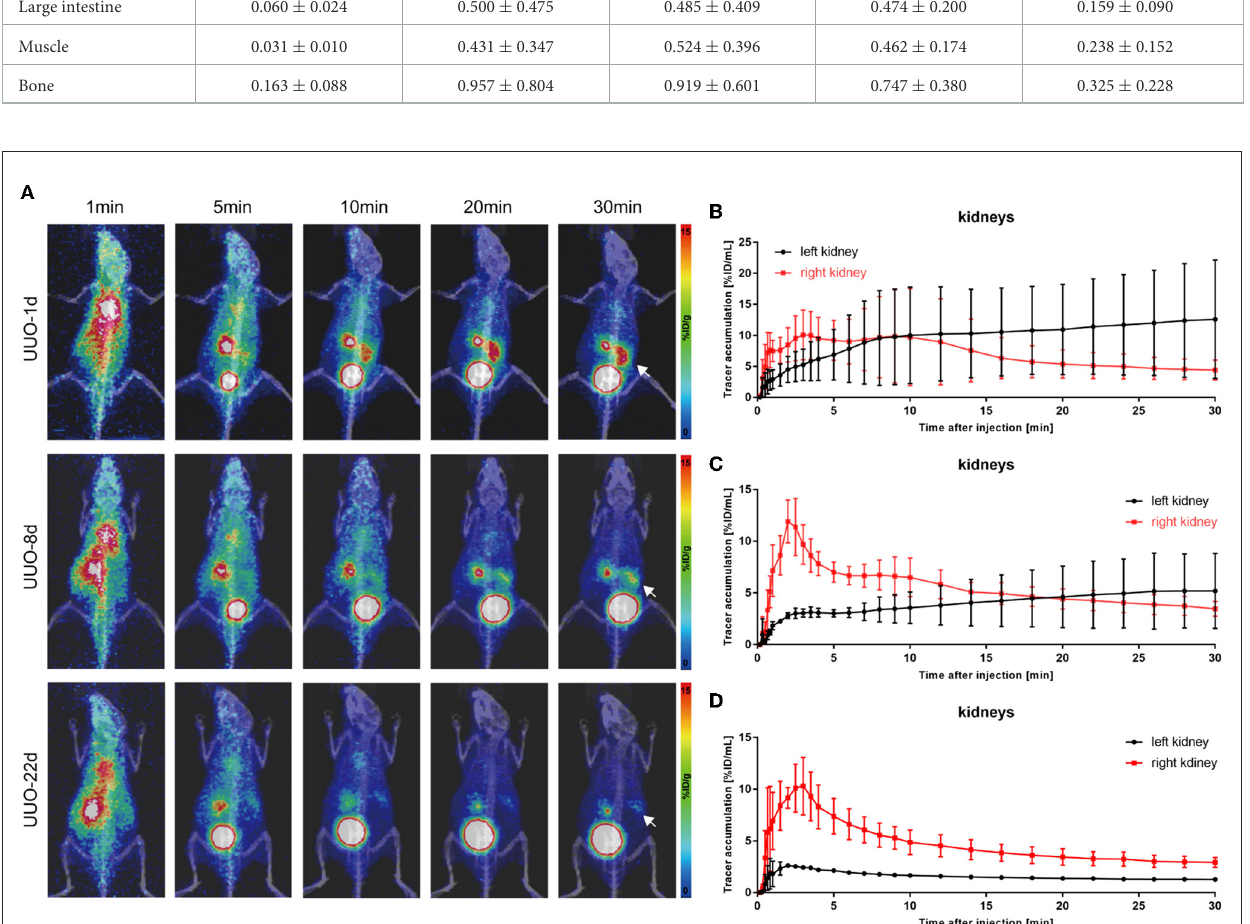
FIGURE3 68 Ga-EDTA dynamic PET/CT imaging of unilateral ureter obstruction (UUO) in mice and the vital renograms. (A) Coronal fusion images of 68 Ga-EDTA dynamic PET/CT scanning on UUO mice on days 1, 8, and 22 after UUO (white arrows, the left ureter was ligated). (B) The renograms of UUO-1d mice were obtained via PET imaging. (C) The renograms of UUO-8d mice were obtained via PET imaging. (D) The renograms of UUO-22d mice were obtained via PET